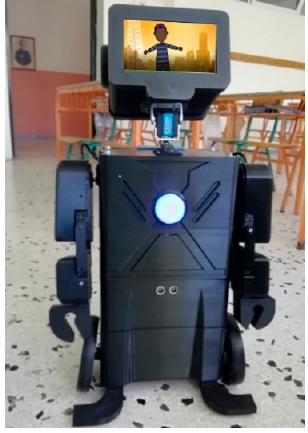
Figure 5. The scenario of Reza in a